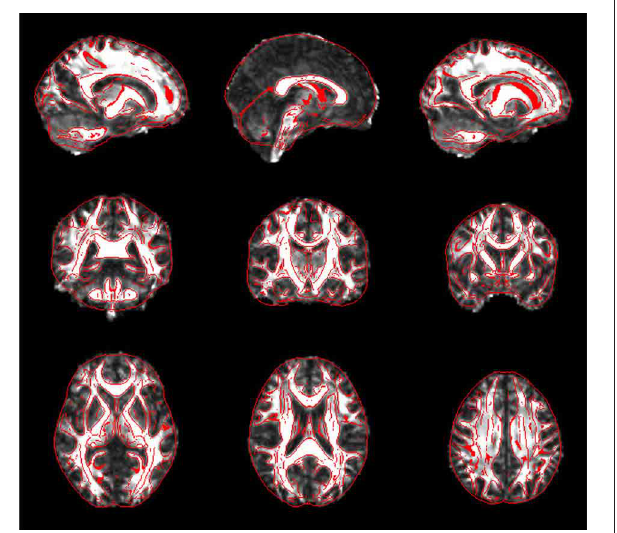
FIGURE 5 | Snapshot pictures for quality control of FA normalization. The normalized FA is overlaid with image edges that were derived from the FA template. These pictures can be quickly viewed to check the quality of